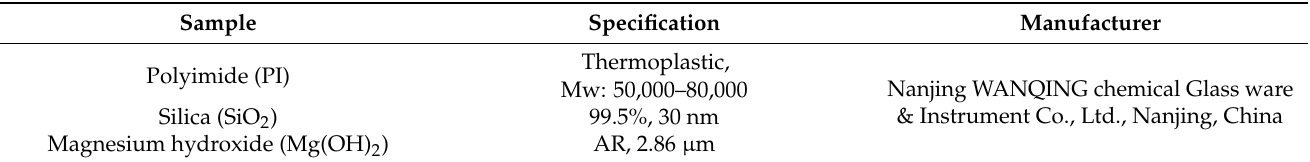
Table 1. Experimental materials.